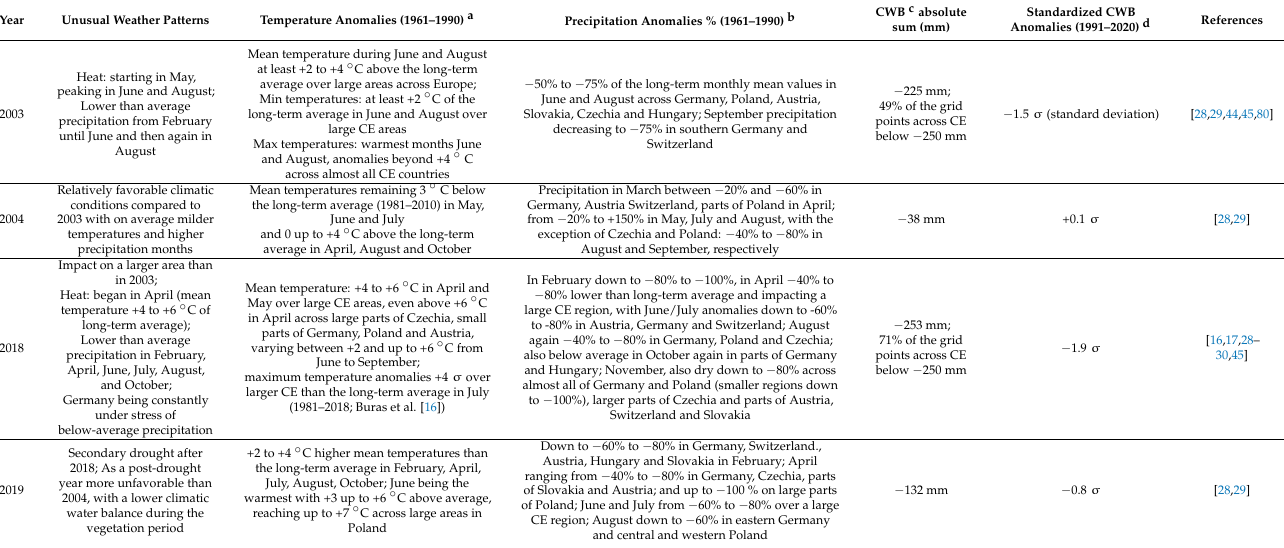
Table 1. Overview of climatic conditions in the drought years 2003 and 2018, and in their post-drought